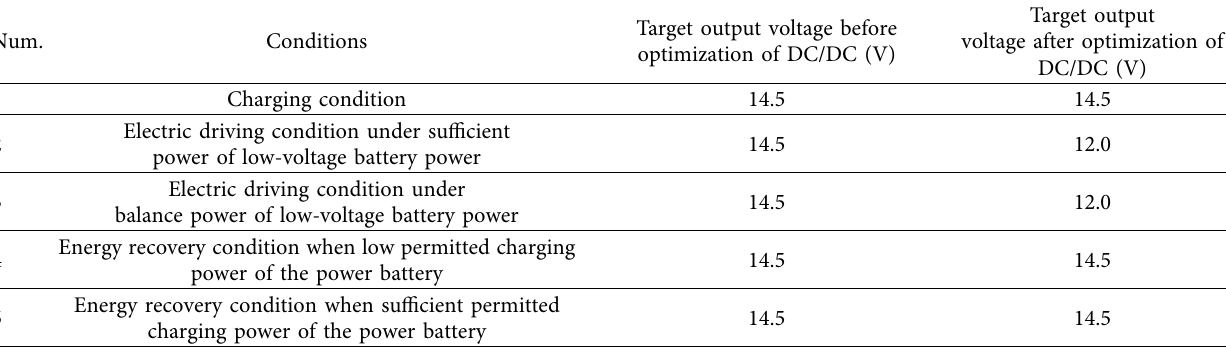
Table 2: Target output voltage of DC/DC.